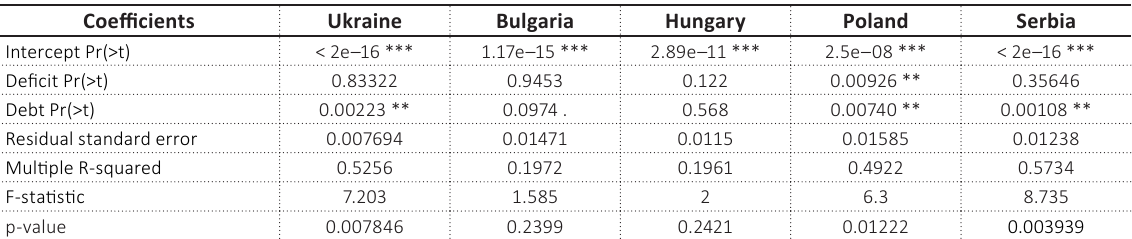
Table A8. Results of modelling for Hypothesis 1 (correlation between budget deficit, public debt and HDІ)